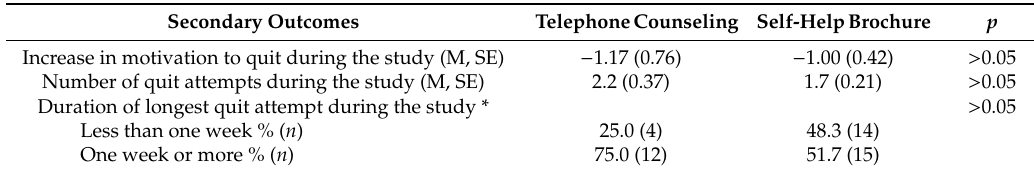
Table 4. Secondary outcomes among parents in the intervention ( n = 21) and control condition. ( n = 33) who did not report abstinence at three months